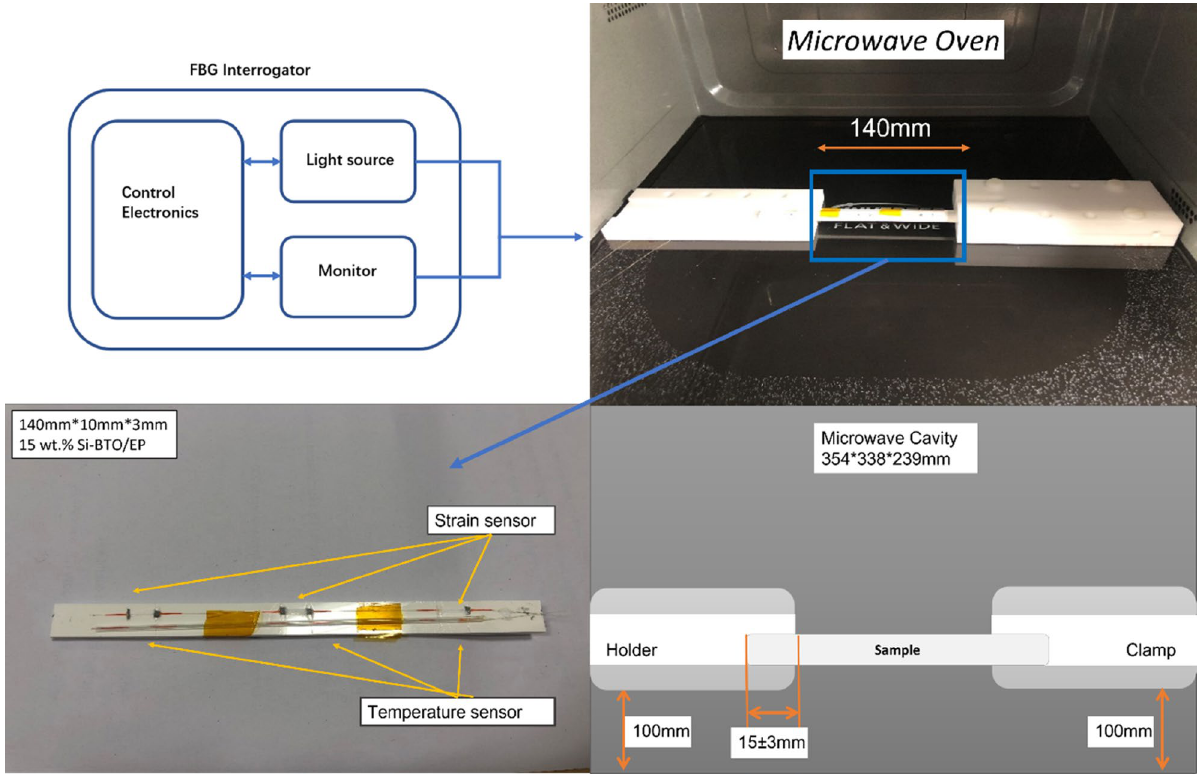
Figure 12. Schematic illustration of the sample of epoxy nanocomposite with BaTiO 3 on the PTFE holder in the microwave oven with surface bonded FBG arrays connected to an